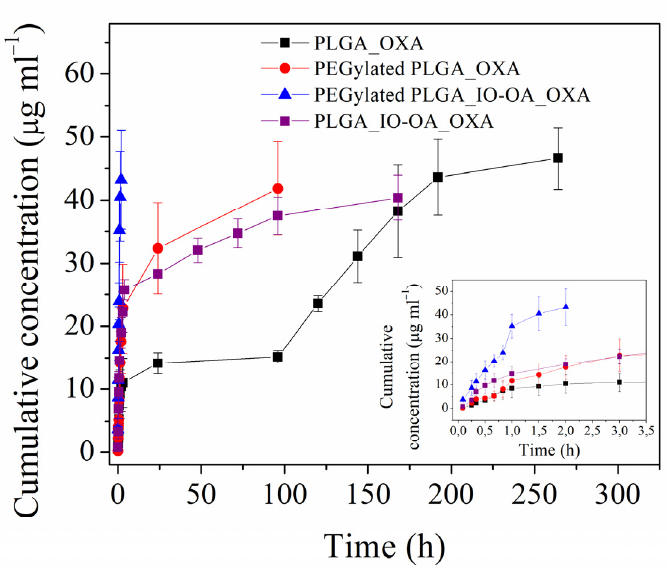
Figure 6. Drug release profiles of oxaliplatin-loaded PLGA nanoparticles (PLGA_OXA), oxaliplatin-loaded PEGylated PLGA nanoparticles (PEGylated PLGA_OXA), PLGA-based multicomponent delivery systems (PLGA_IO-OA_OXA) and PEGylated PLGA-based multicomponent delivery sys- tems (PEGylated PLGA_IO-OA_OXA) in PBS pH 7.4 at 37 °C.